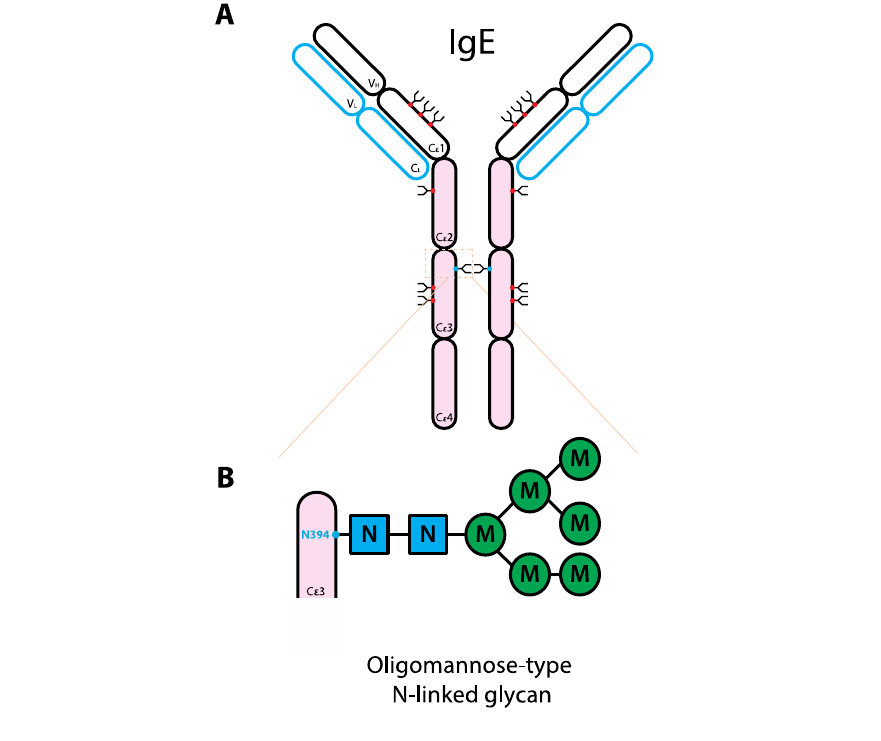
) and the H ) and constant regions L